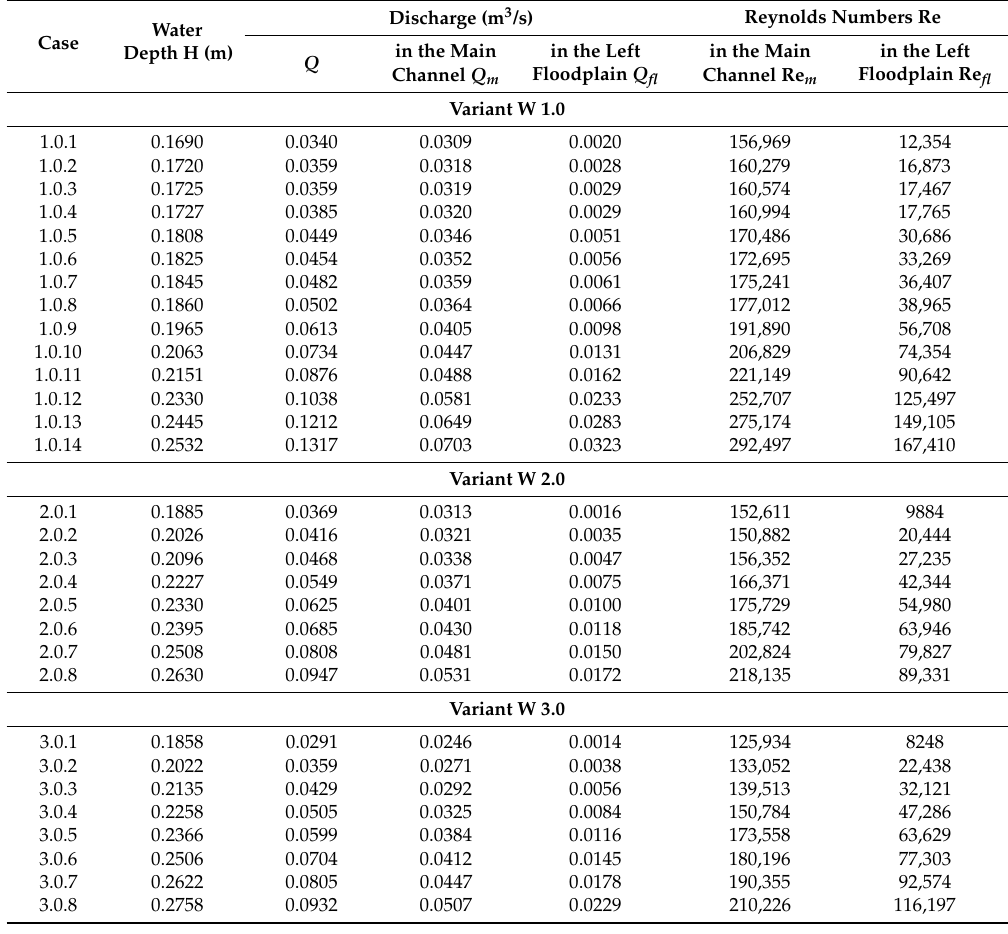
Table 1. Experimental variants with stream interactions.